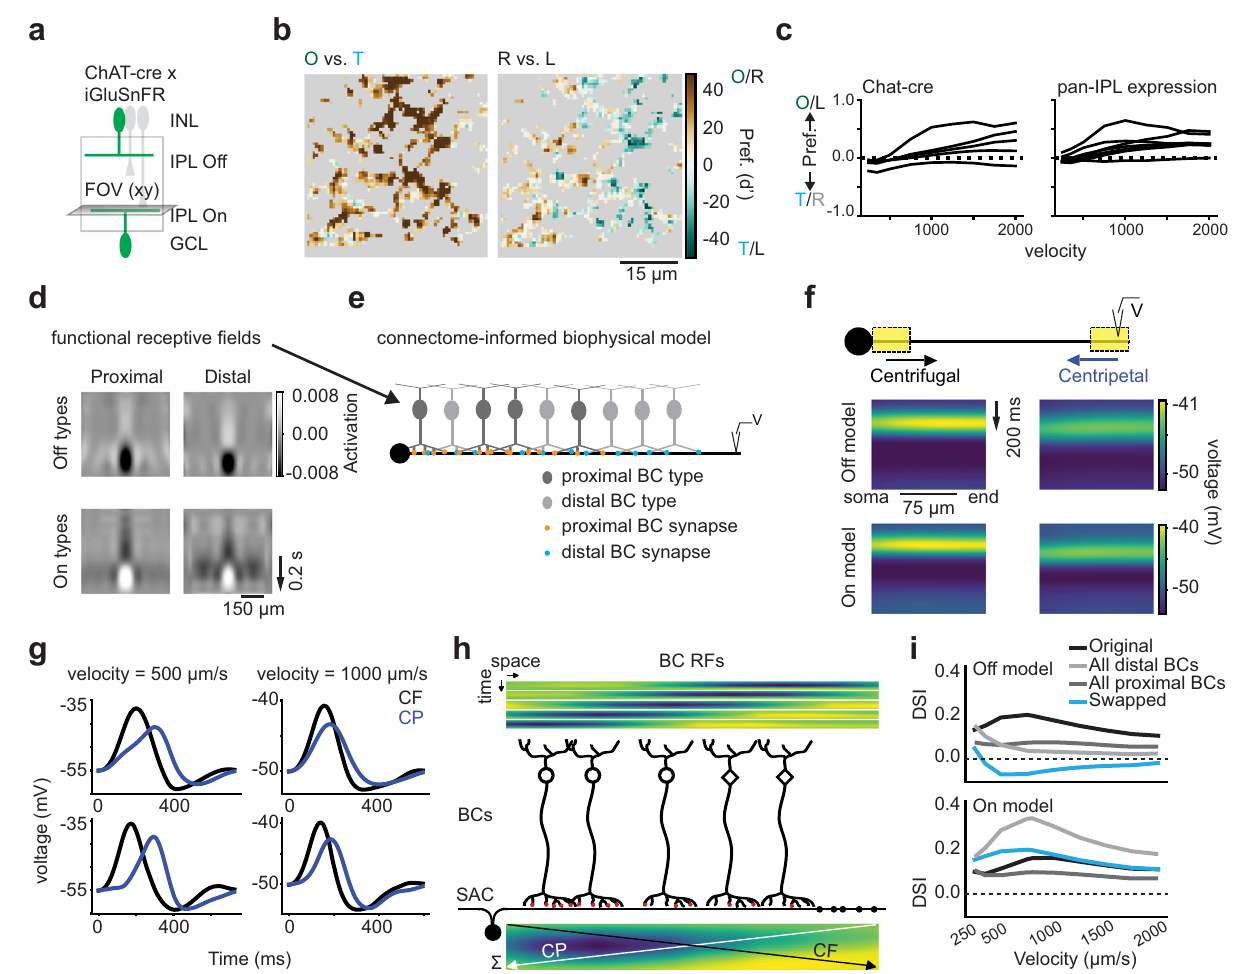
Fig. 6 | Bipolar cell inputs to starburst amacrine cells are radially direction selective and model amacrine cell inherits bipolar cell motion information. a fl ex-iGluSnFRwasinjectedintoChAT-cremicetoachieveSAC-speci fi clabelingof glutamate inputs. b The motion preference (d') for all ROIs in an example imaging fi eld showing rDS. “ O ” , originating; “ T ” , terminating; “ L ” , left; “ R ” , right. For details see Supplementary Fig. 9. c Comparison of rDS velocity tuning curves for On BC clustersidenti fi edfrom miceexpressingiGluSnFR onlyinthe SACs(left, ChAT-cre) vs. ubiquitously (right, from Fig. 2). For details see Supplementary Fig. 10. d Up- sampledfunctionalRFs of four BCclustersselectedbasedon co-strati fi cation with SAC-connected BCtypes. e Ball-and-stickmulti-compartment modelofa singleOn SAC dendrite with BC inputs organized according to anatomical and physiological data. f MembranepotentialalongthedendriteinanOff(top)andOn(bottom)SAC model during centrifugal ( “ CF ” ) and centripetal ( “ CP ” ) motion of a moving bar